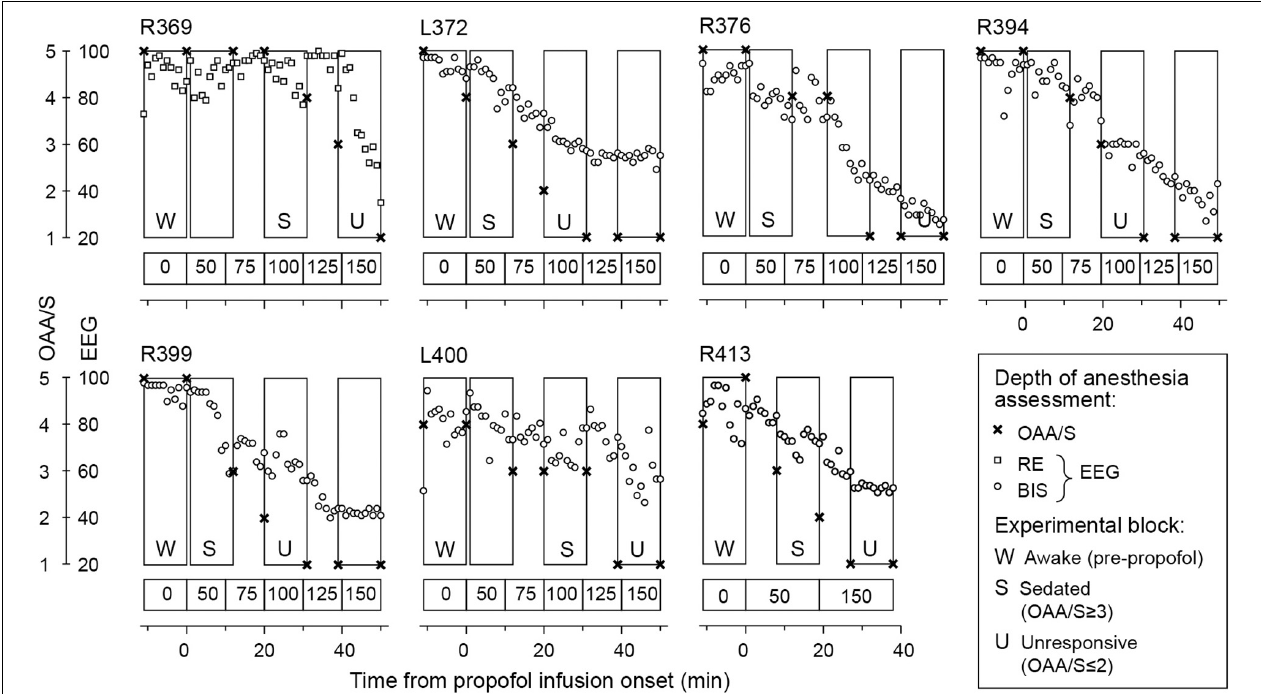
FIGURE 2 | Induction of general anesthesia. Observer’s Assessment of Alertness/Sedation (OAA/S) scores (crosses) and electroencephalographic (EEG) sedation indices are plotted as functions of time. EEG-based sedation indices were response entropy [RE] in subject R369 and bispectral index (BIS) in all other subjects (open squares and circles, respectively). Rectangles denote 11-min LGD experimental blocks; letter labels indicate the three arousal states (W: awake, S: sedated, U: unresponsive). Propofol infusion rates are shown underneath each plot.